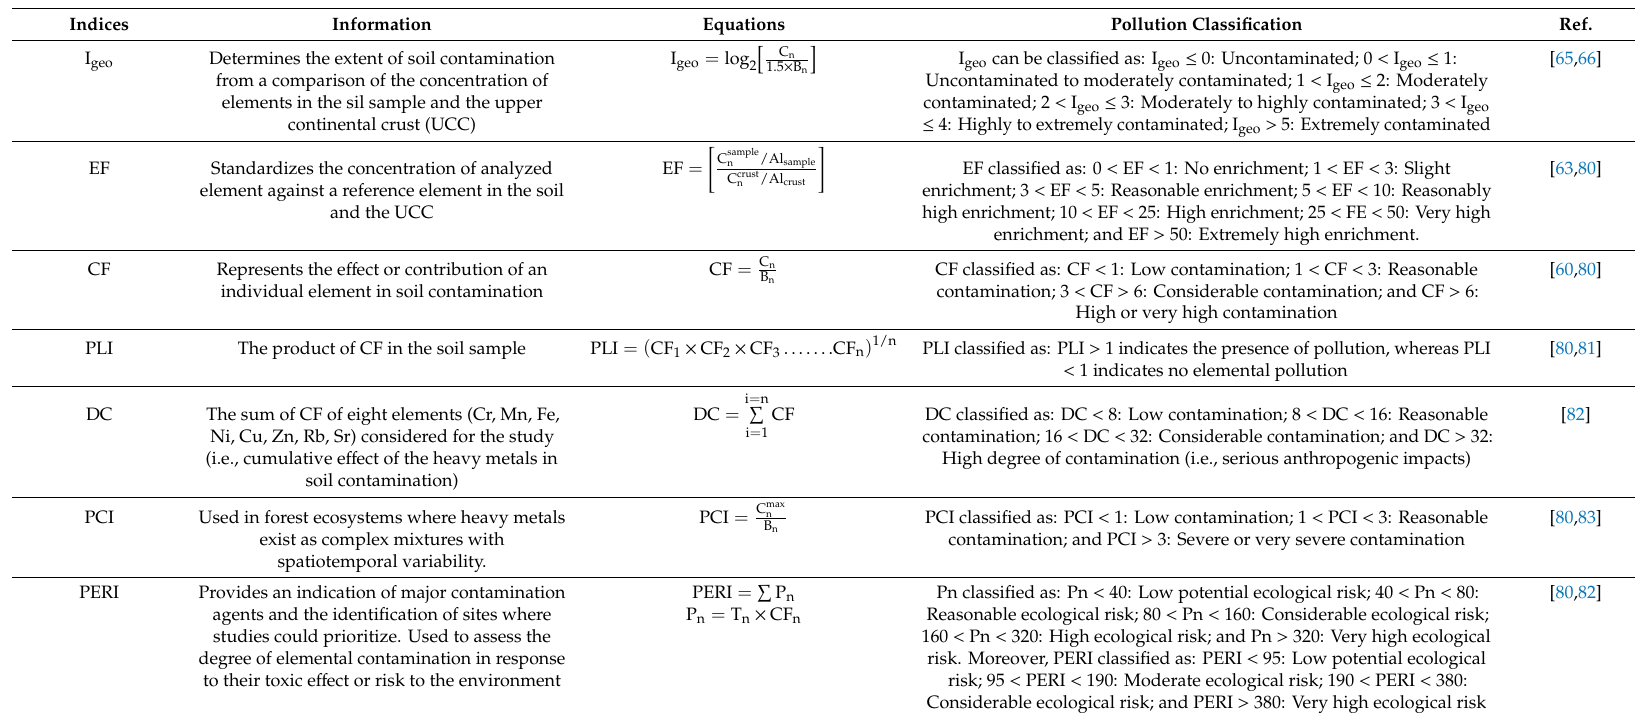
Table 2. Indices used to assess ecological risk for study